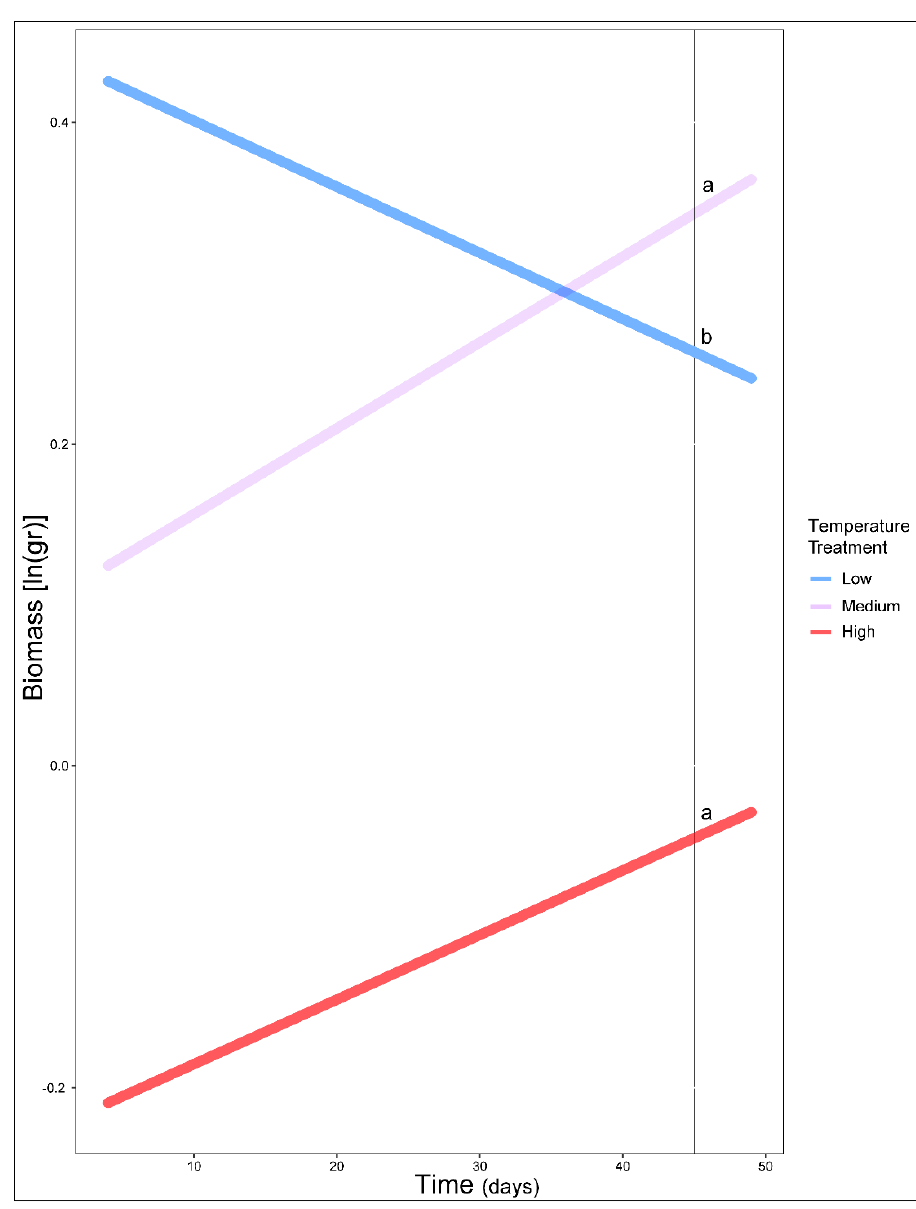
Figure 1. Estimated performance of Erebia caterpillars as predicted for the three temperature treat- ments (low, medium, high) and across time. Lowercase letters indicate differences between treatments. Model fitted for individuals that had two or more mass measurements. Note that hatching time slightly varied among larvae, resulting in different biomass at the beginning of weekly measurements (see